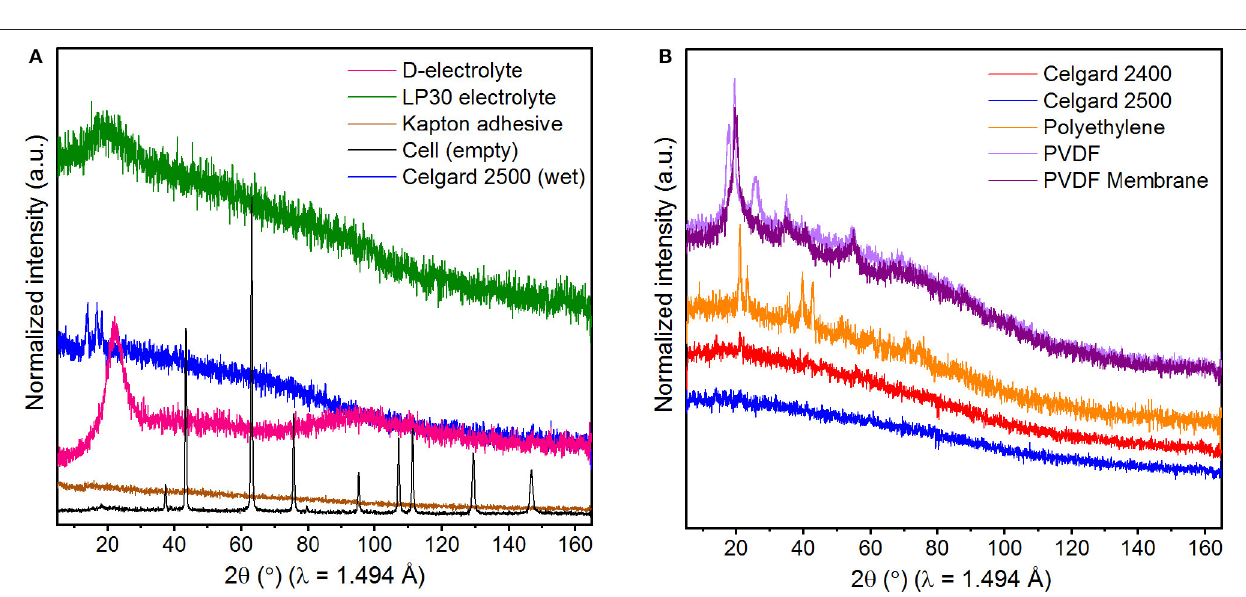
Data Treatment and Refinement Protocol